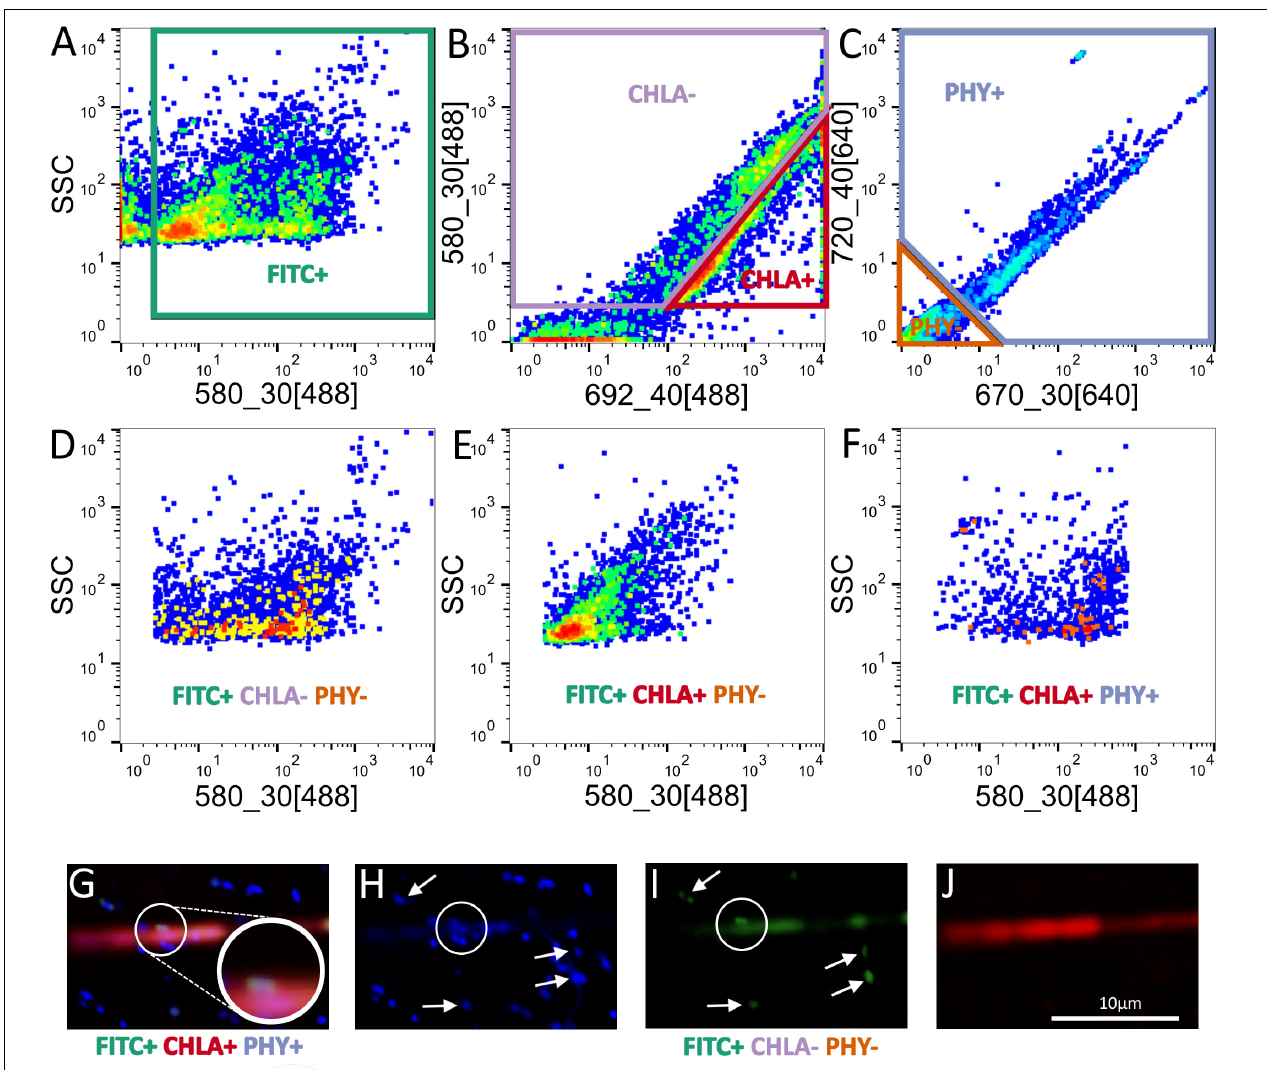
FIGURE 2 | Dot plot with pseudo-color visualization of the sorted cell fractions and their gating strategy. (A) FITC gate in the side scatter vs. 580 nm (blue laser) dot plot (FITC+, gate in green). (B) Chlorophyll a gate in the 580 nm (blue laser) vs. 692 nm (blue laser) dot plot (CHLA+, gate in red). (C) Phycocyanin gate in the 720 nm (red laser) vs. 670 nm (red laser) dot plot (PHY+, gate in blue). Sorted cell fractions plotted (ssc vs. 580 nm (blue laser) are shown in the row below, gated with Boolean gating. (D) Free living MOB-like cells (gated as FITC+, CHLA–, PHY–). (E) Active MOB-like cells attached to algae (gated as FITC+, CHLA+, PHY–). (F) Active MOB-like cells attached to cyanobacteria (gated as FITC+, CHLA+, PHY+). (G) Three-channel depicts the presence of FITC+ cells (MOB-like cells, FITC fluorescence in green) attached to a filamentous cyanobacterium (Chlorophyll α autofluorescence in red). The inset depicts the presence of MOB-like cells (FITC +) on the filament. (H) DAPI stained cells. The circle shows the cells that were FITC+ on (G,I) . (I) Presence of FITC+ cells on the filament (circle), and the arrows show FITC + cells corresponding to free MOB-like cells. (J) Natural Chl a autofluorescence (red) from a